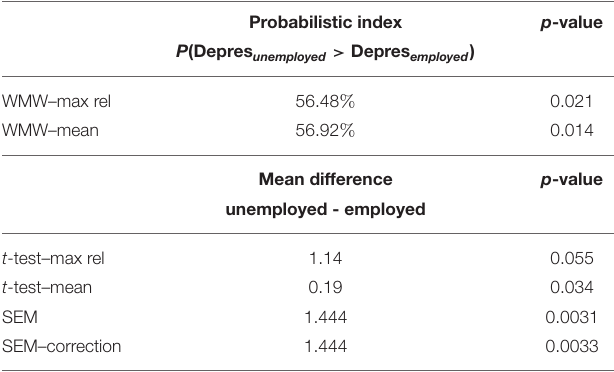
TABLE 5 | Effect sizes and inference based on the extended WMW methods, default and corrected SEM and the adapted t -tests when comparing the latent outcome variable depression between employed and unemployed patients with